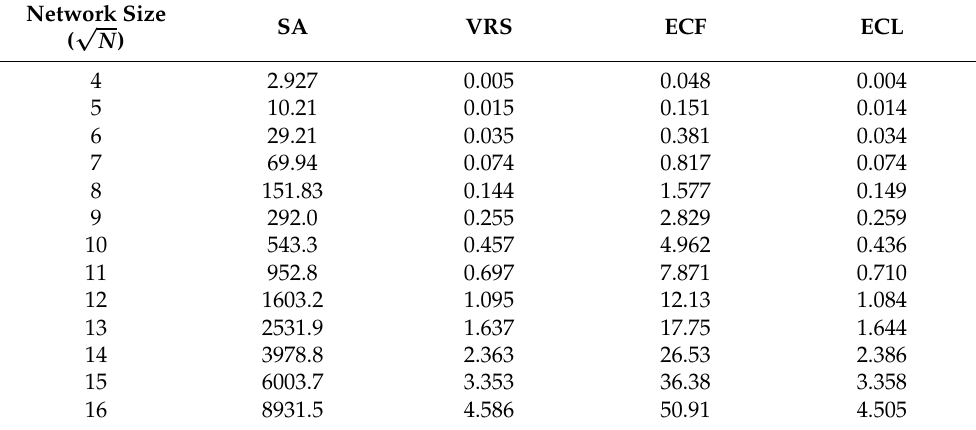
Table 1. Computation time (in seconds) required for different sizes of torus